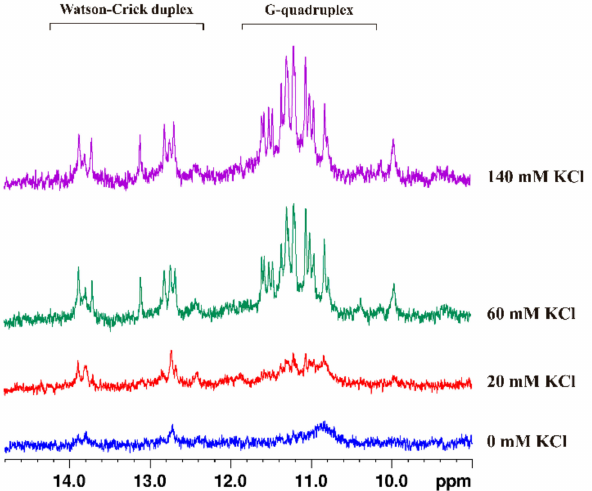
Figure 7. Study of KCl effect in the secondary structure of AS1411-N6 by 1 H NMR spectroscopy. Two distinct sets of signals are observable upon KCl titration, corresponding to duplex base pairing and G4 portion. Shown on top of the image are these signal sets,